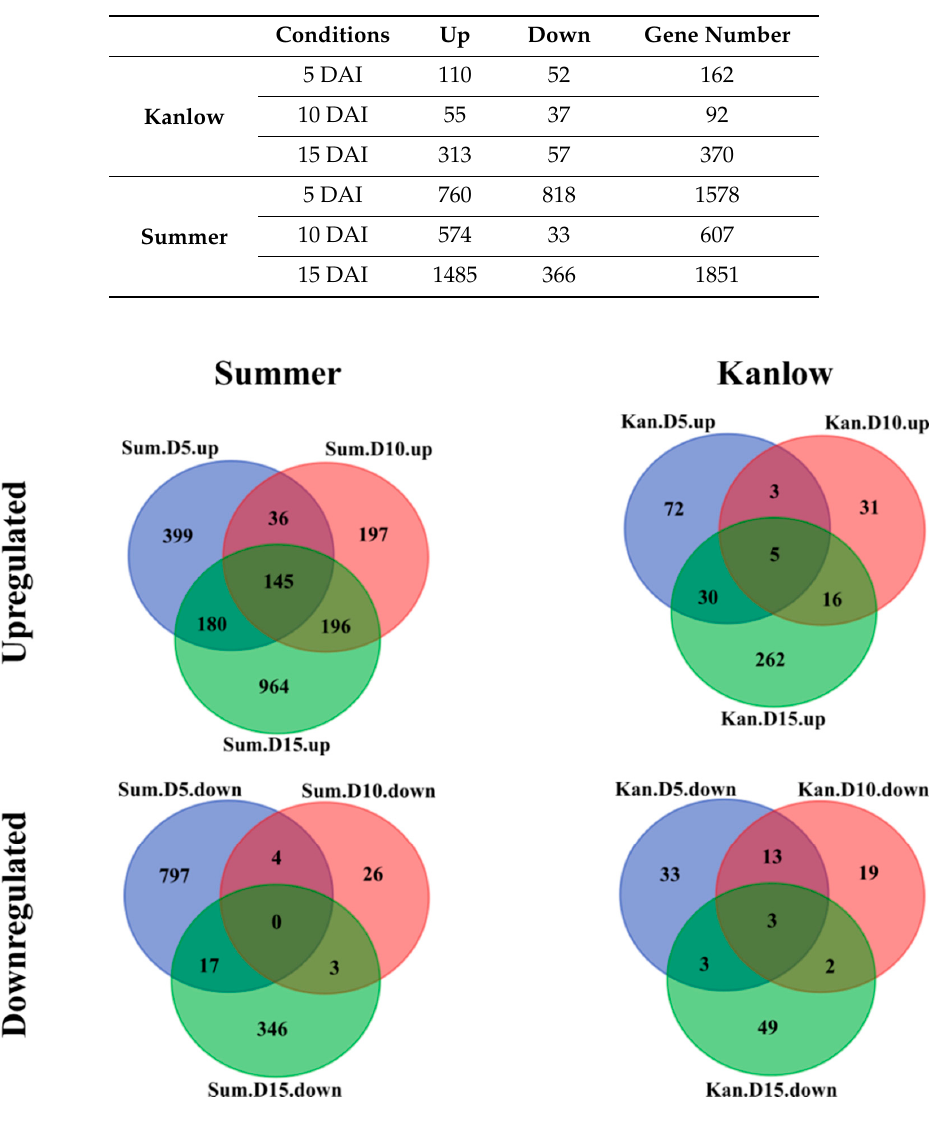
Table 1. Number of di ff erentially expressed genes (DEGs) under di ff erent conditions.